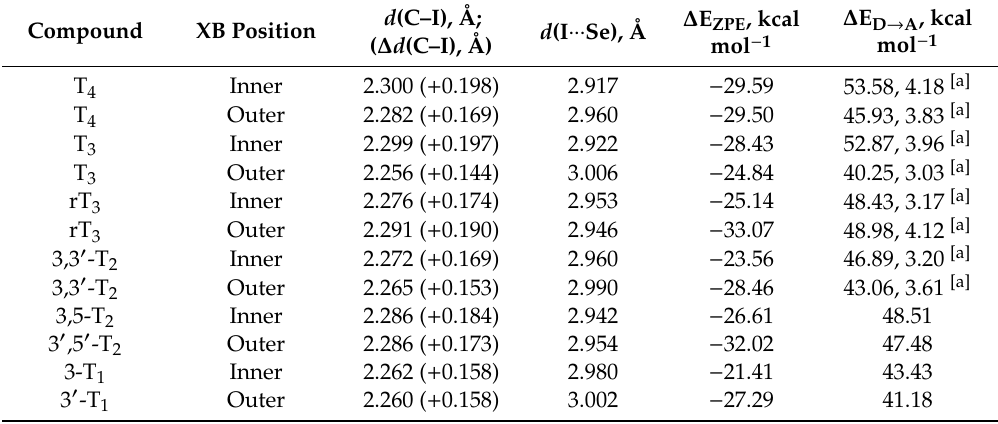
Table 1. Interaction energies and selected distances for halogen bonding (XB) complexes of TH analogues with MeSe − at each unique iodine center, adapted from reference